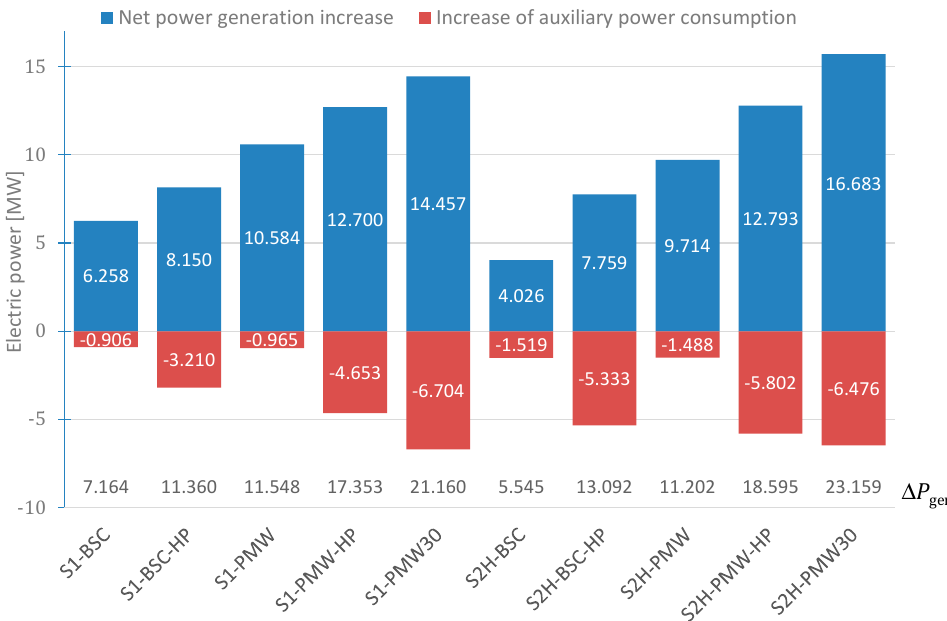
Figure 5. Change of net power generation (blue), auxiliary consumption (red), generator power (number at the bottom) with different heat recovery schemes. PMW30 is only implemented with heat pumps; HP at the end of other heat recovery schemes indicates the use of heat pumps.